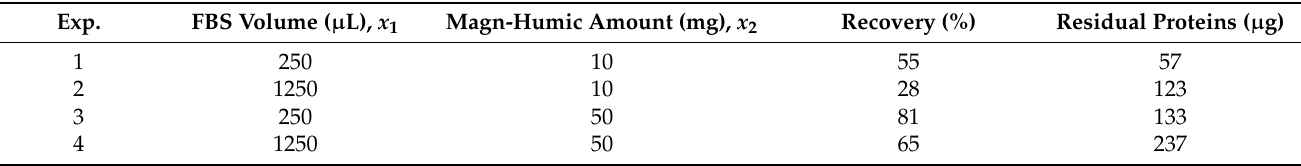
Table 3. Mean multiclass recovery ( n = 3), average of all analytes recoveries of each experiment, and residual protein in the magnetic solid-phase extraction (MSPE) eluate obtained in the conditions of the experimental plan.